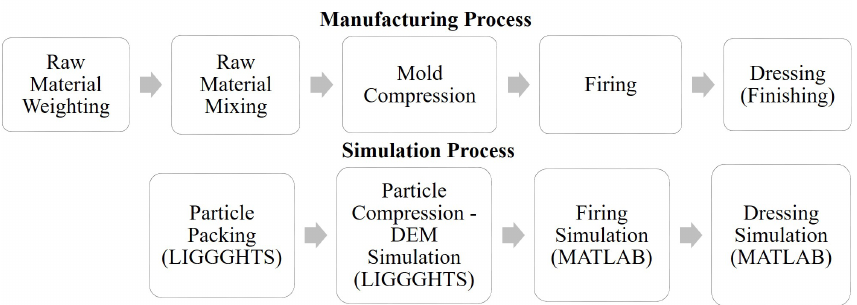
Figure 4. Simulation process in comparison to manufacturing process; adapted based on [16].